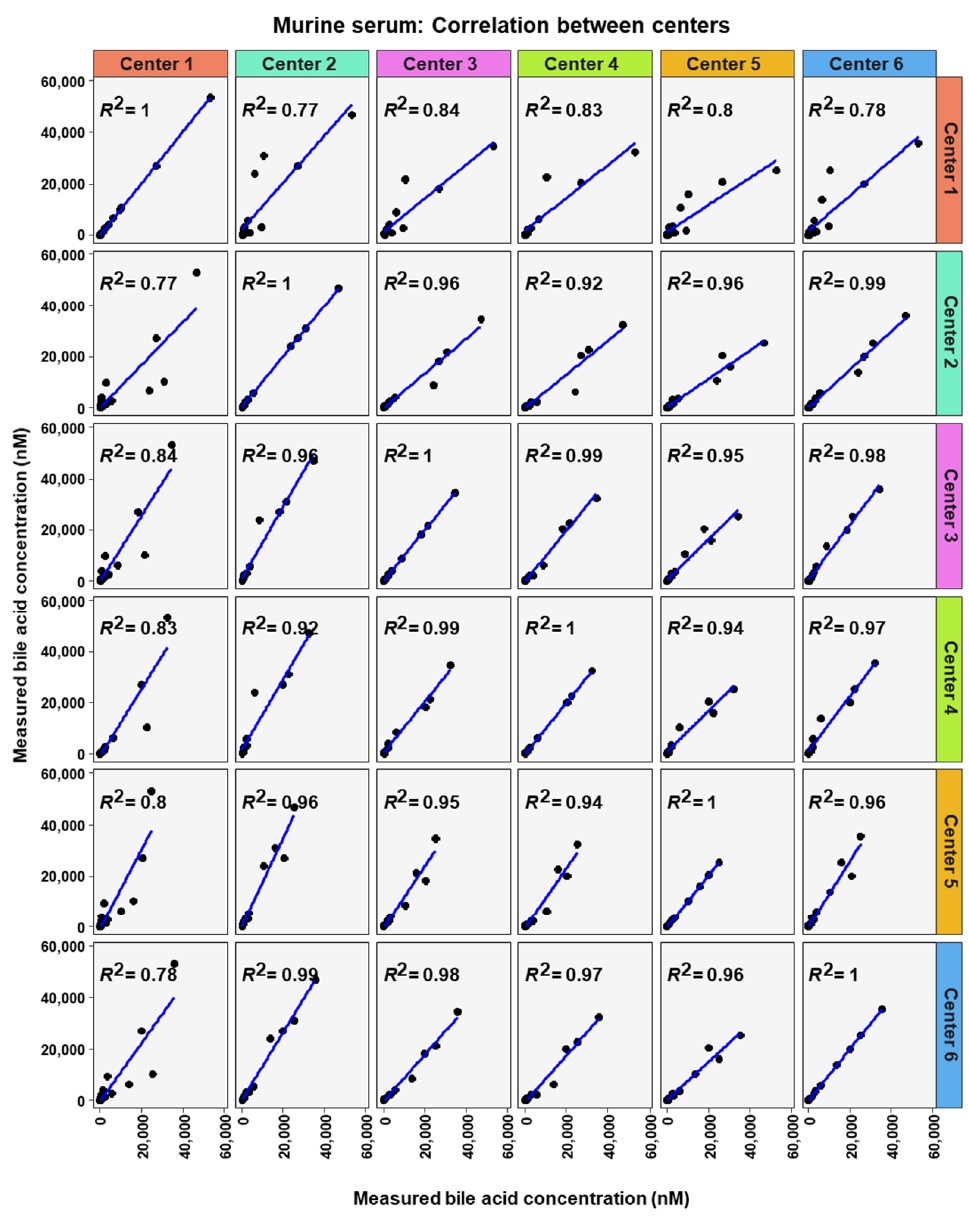
Figure 9. Correlation of bile acid quantification between assessing centers for measurements of bile acid in murine serum.